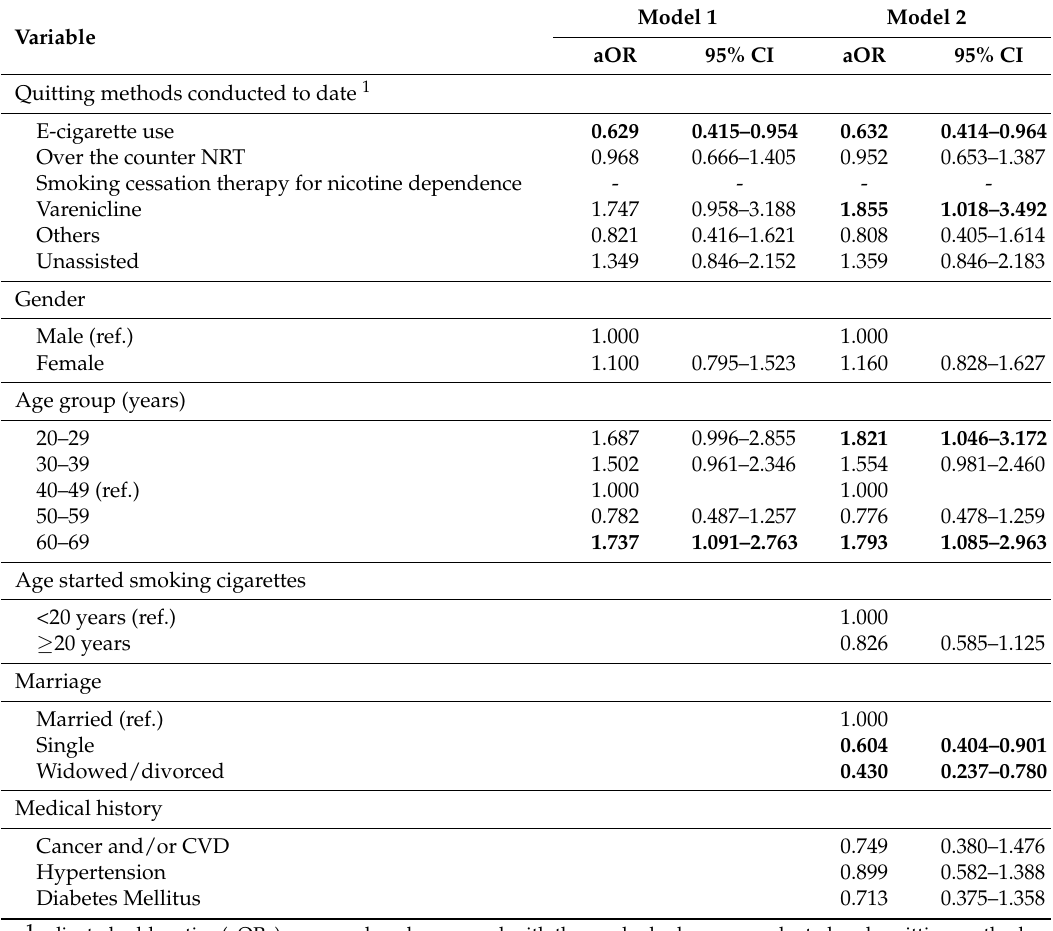
Table 2. Adjusted odds ratios (95% CIs) for smoking cessation within 5 years, according to quitting methods and socio-demographic factors, among 253 successful quitters and 545 unsuccessful quitters. Model